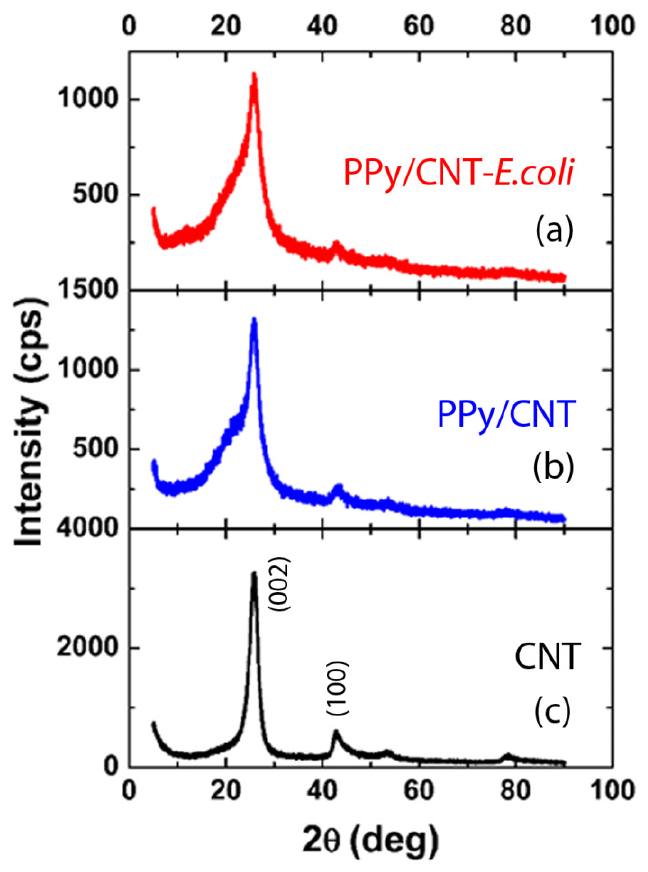
Figure 2. X-ray diffraction pattern of ( a ) Ppy/CNT- E. coli nano-composites, ( b ) Ppy/CNT nano-composite, and ( c ) pure CNT.